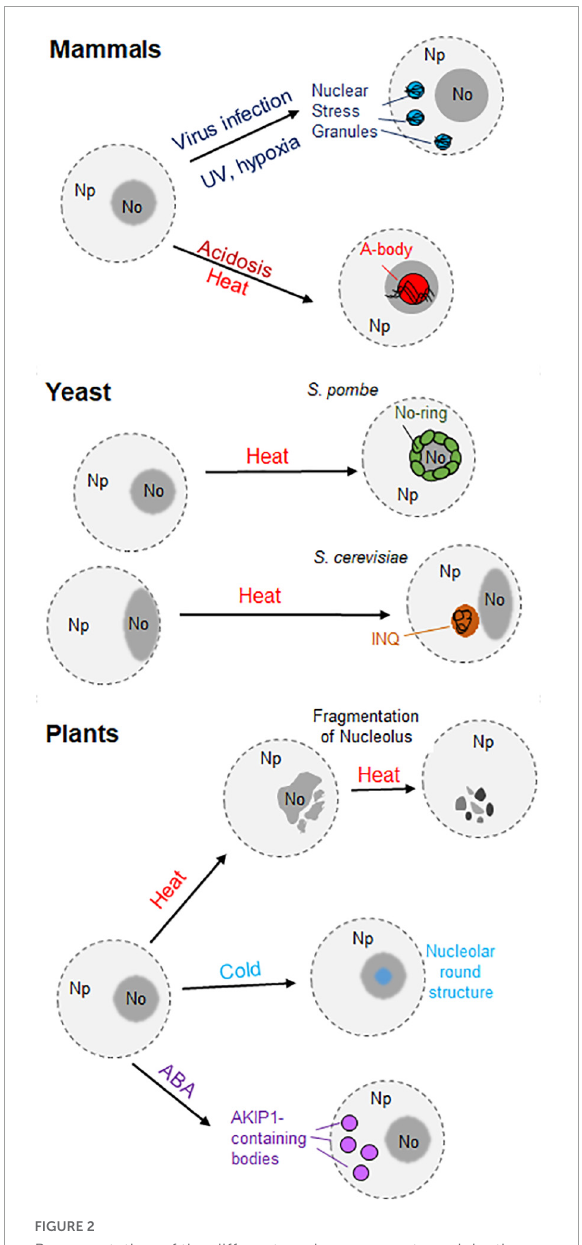
FIGURE2 Representation of the different nuclear aggregates originating under stress conditions in mammals, yeast, and plants. In mammal cells (top) two different nuclear granules are represented: the nuclear stress granules (SGs), formed in the nucleoplasm (Np) upon viral infection, hypoxia or UV exposure; and the A-bodies, formed in the nucleolus (No) in response to acidosis or heat stress. In the middle, the generation of nuclear aggregates in yeast is driven by acute heat stress. While nuclear/nucleolar proteins form the nucleolar ring (No-Ring) in fission yeast ( Schizosaccharomyces pombe ), the intra-nuclear quality-control compartment (INQ) appears in the nuclei of budding yeast ( Saccharomyce cerevisiae ) in contact with the nucleolus. On the bottom, the loss of the nucleolar structure occurs in plant cells upon heat stress, whereas the presence of a round structure occurs during chilling temperatures. Moreover, the formation of AKIP1-containing bodies in the nucleus was observed in Vicia faba in the presence of abscisic acid